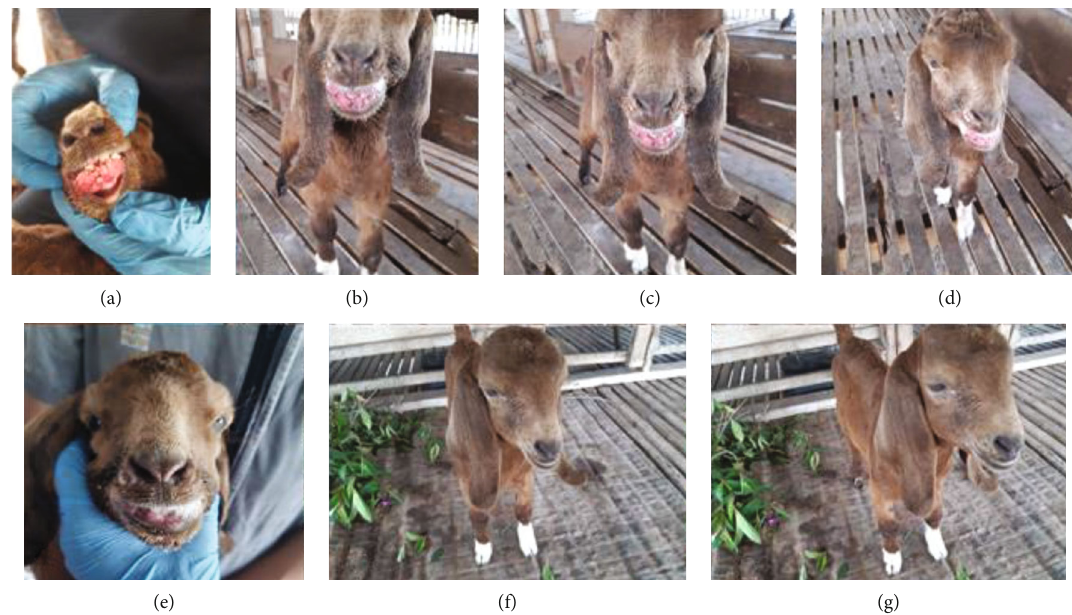
Figure 3: The progression of treatment after administration of fl unixin meglumine, Penstrep (procaine penicillin, dihydrostreptomycin sulphate), and Vitavet (multivitamin – vitamins A, D3, and B12). There was marked regression of the oral mass fi brosis growth from (a) commencement of treatment to (g) fi nal